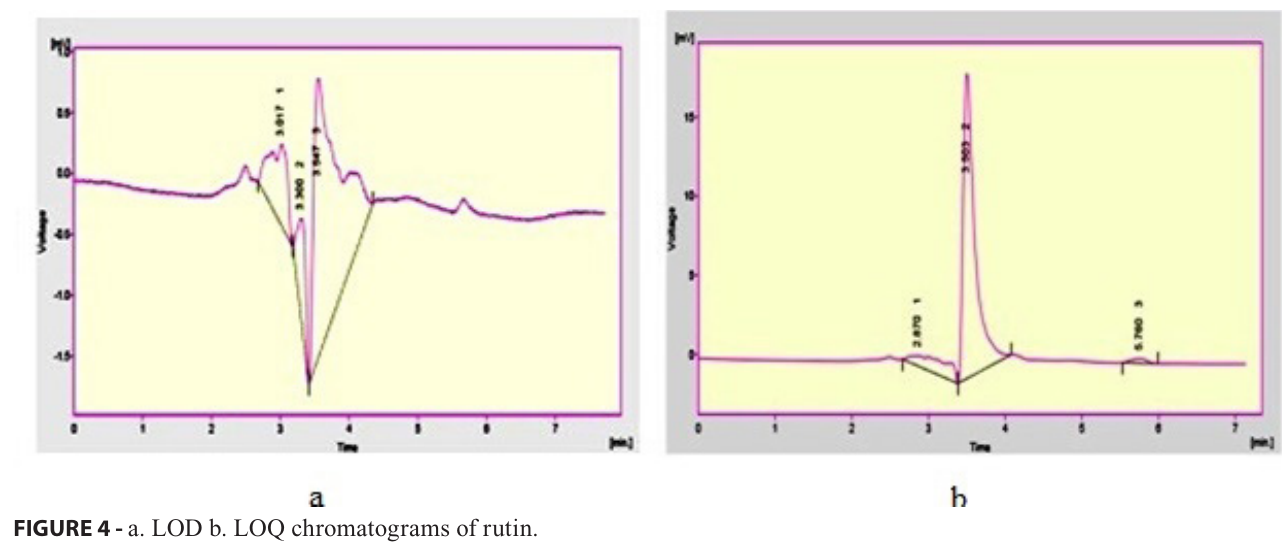
FIGURE 4 - a. LOD b. LOQ chromatograms of rutin.